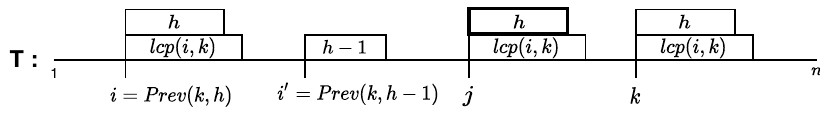
Figure 2. Let h ∈ C (cid:48) and i = Prev ( k , h ) . By contradiction, assume that there exists j ∈ ( i , k ) such that k j = Prev ( k , lcp ( i , k )) . Since h ≤ lcp ( i , k ) , T [ j , j + h − 1 ] = T [ k , k + h − 1 ] . This is a contradiction with i = Prev ( k , h ) . Thus, i = Prev ( k , lcp ( i , k ))